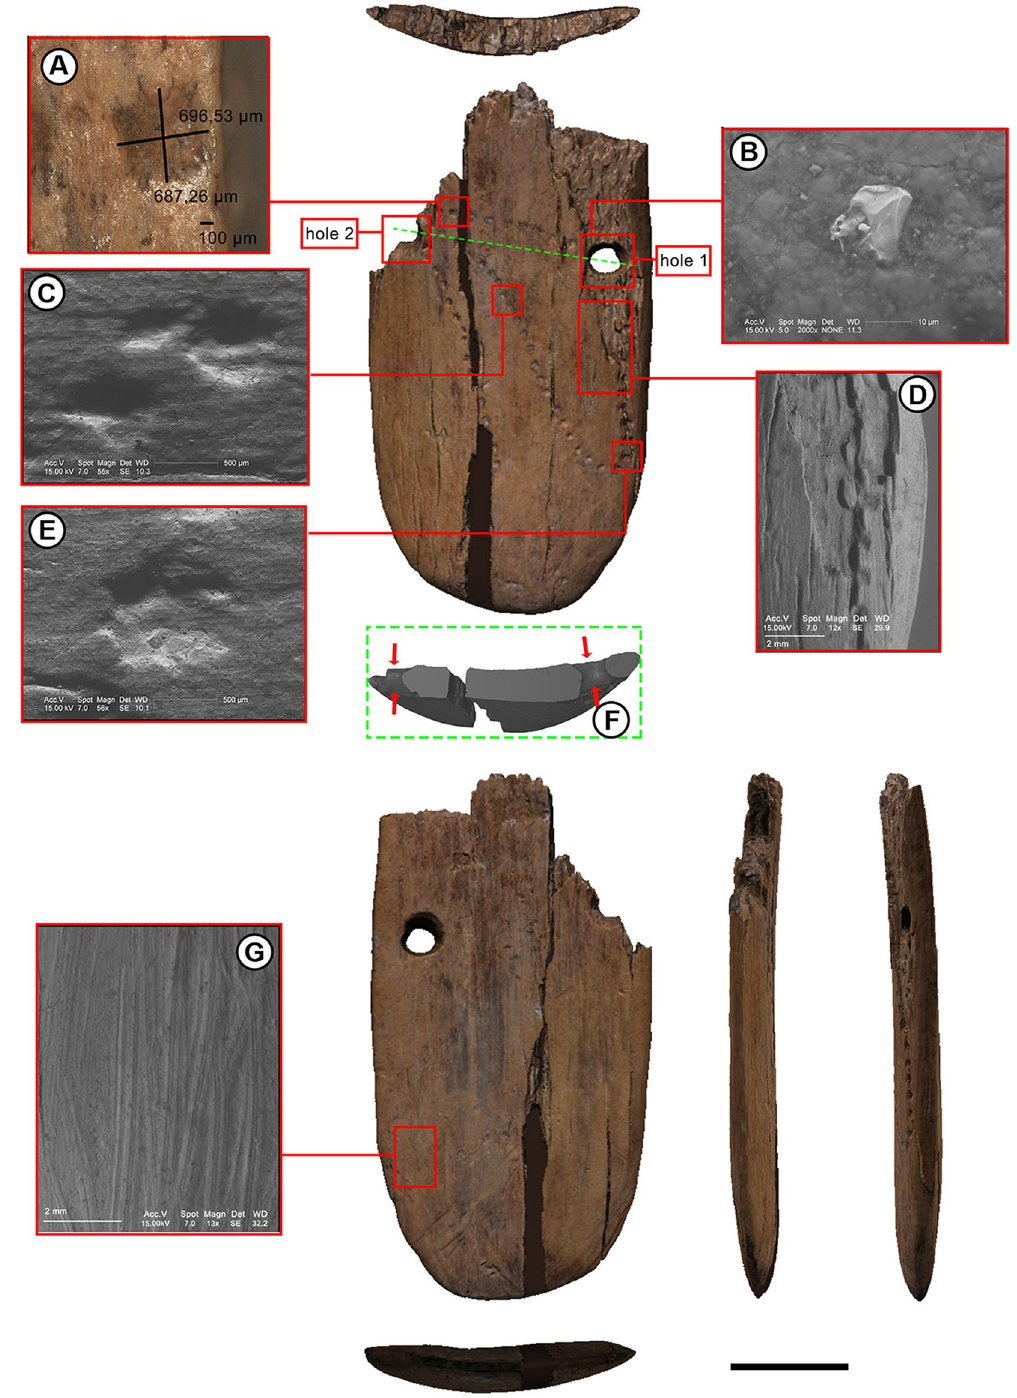
Figure 2. Stajnia pendant reconstruction. Views of the virtually reconstructed pendant and photomicrographs documenting the technology used for their manufacture: multiple examples of punctures ( A , C – E ) and traces of smoothing ( B , G ). A longitudinal section through perforations is shown in (B). Scale bar is 1